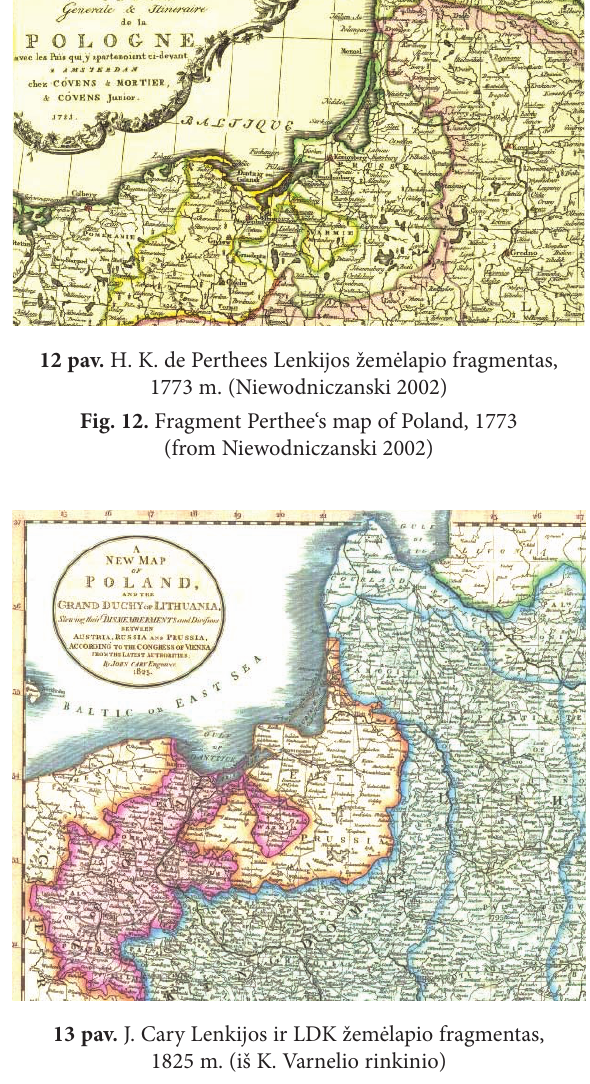
Fig. 13. Fragment j. Cary map of Poland and Grand Duchy of Lithuania, 1825 (from K. Varnelis collection)